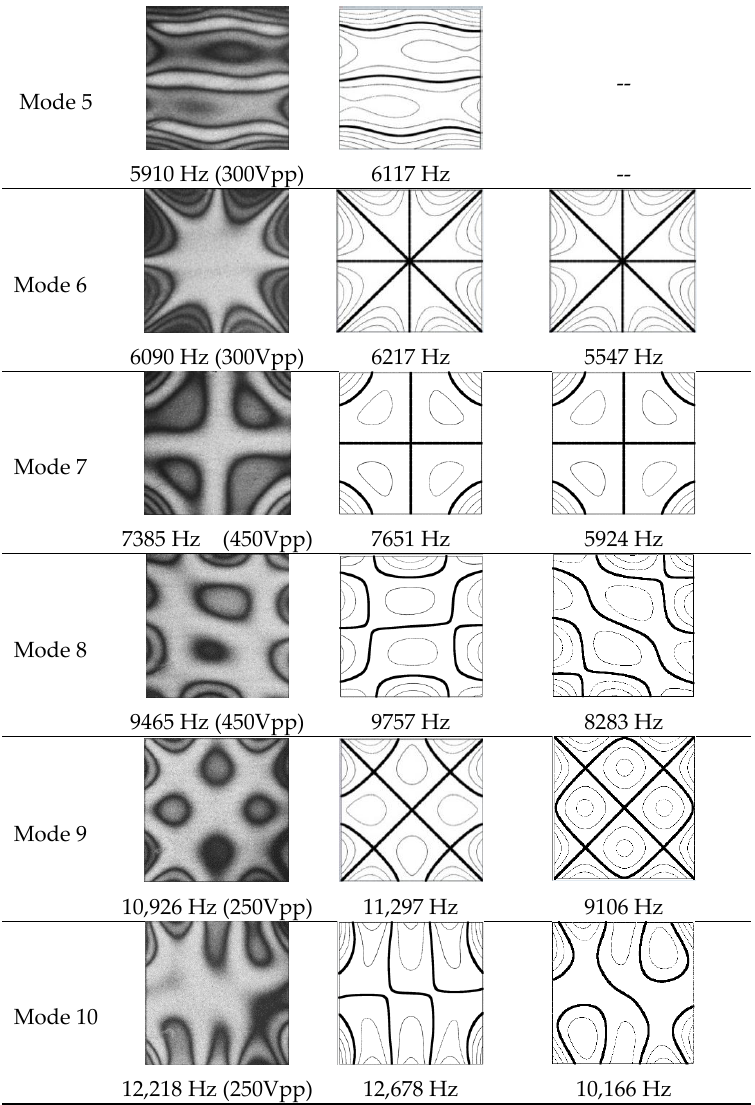
Figure 7. Out-of-plane vibration modes for FUJI C-2.